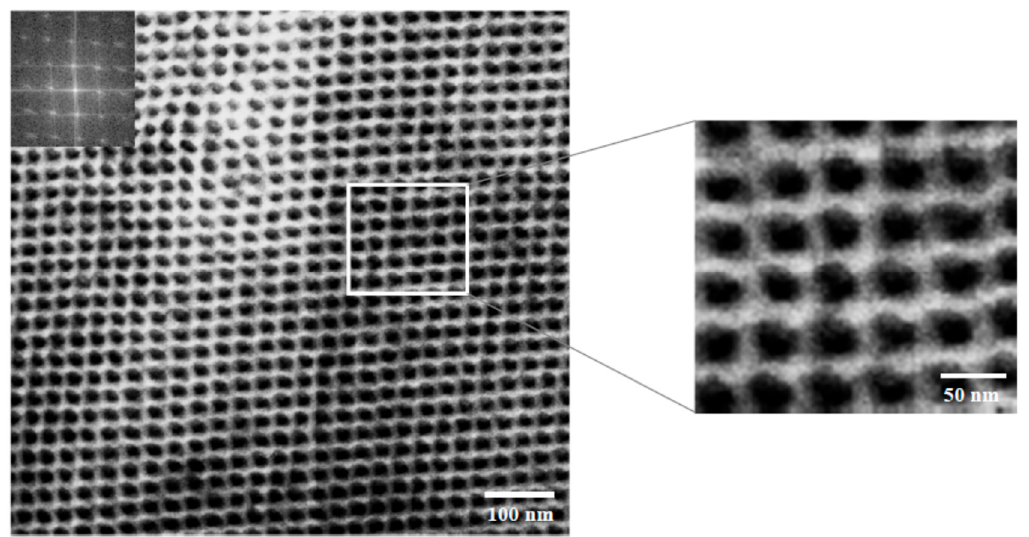
Figure 3. Bright ‐ field TEM image, and a “magnified area” for enhancing details, exhibiting approximately a [111] projection. The insert at the upper left of the TEM image is the corresponding FFT. White areas correspond to PS domains, grey areas to 3,4 ‐ PI blocks and the black areas to the PB segments after staining with OsO 4 for approximately 30 min.